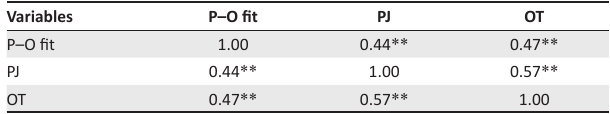
TABLE 2: Correlation matrix of the variables.